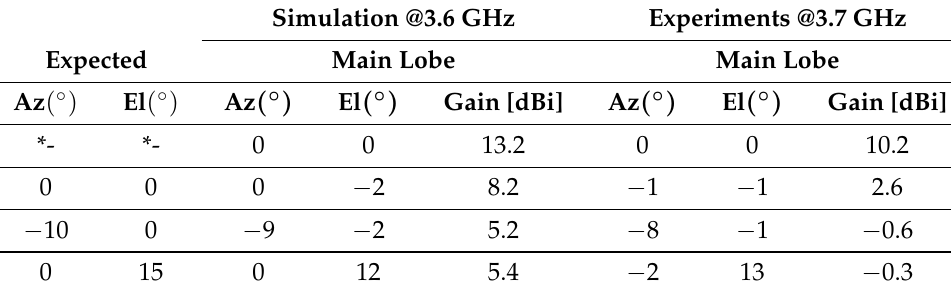
Table 2. Summary table for simulated and measured radiation